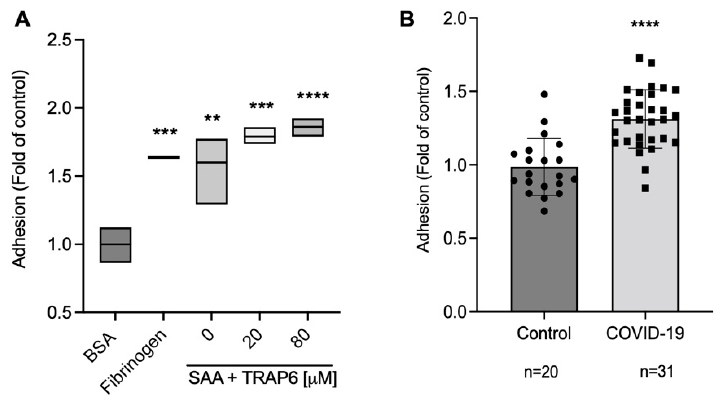
Figure 4. COVID-19 serum proteins increase platelet adhesion. ( A ) Adhesion of platelets to immobi- lized proteins. Microtiter plates were precoated with the indicated proteins in triplicates. Platelet suspensions from a healthy individual were then added to the wells. Adhesion was determined using the acid phosphatase assay. BSA was used as a negative control for background adhesion. Recombinant SAA and fibrinogen served as positive controls. TRAP-6, a platelet activator, was used to increase SAA binding in the indicated wells. Values are the mean ± standard deviation from three independent experiments. Ordinary one-way ANOVA, Dunnett’s multiple comparisons test, ** p < 0.002, *** p < 0.0002, **** p < 0.0001. ( B ) Adhesion of platelets to COVID-19 patient serum. Microtiter plates were precoated overnight with COVID-19 ( n = 31) or control serum (patients with non-inflammatory diseases or healthy individuals, n = 20). Platelet suspensions from healthy individuals were added to the wells. Adhesion was determined using the acid phosphatase